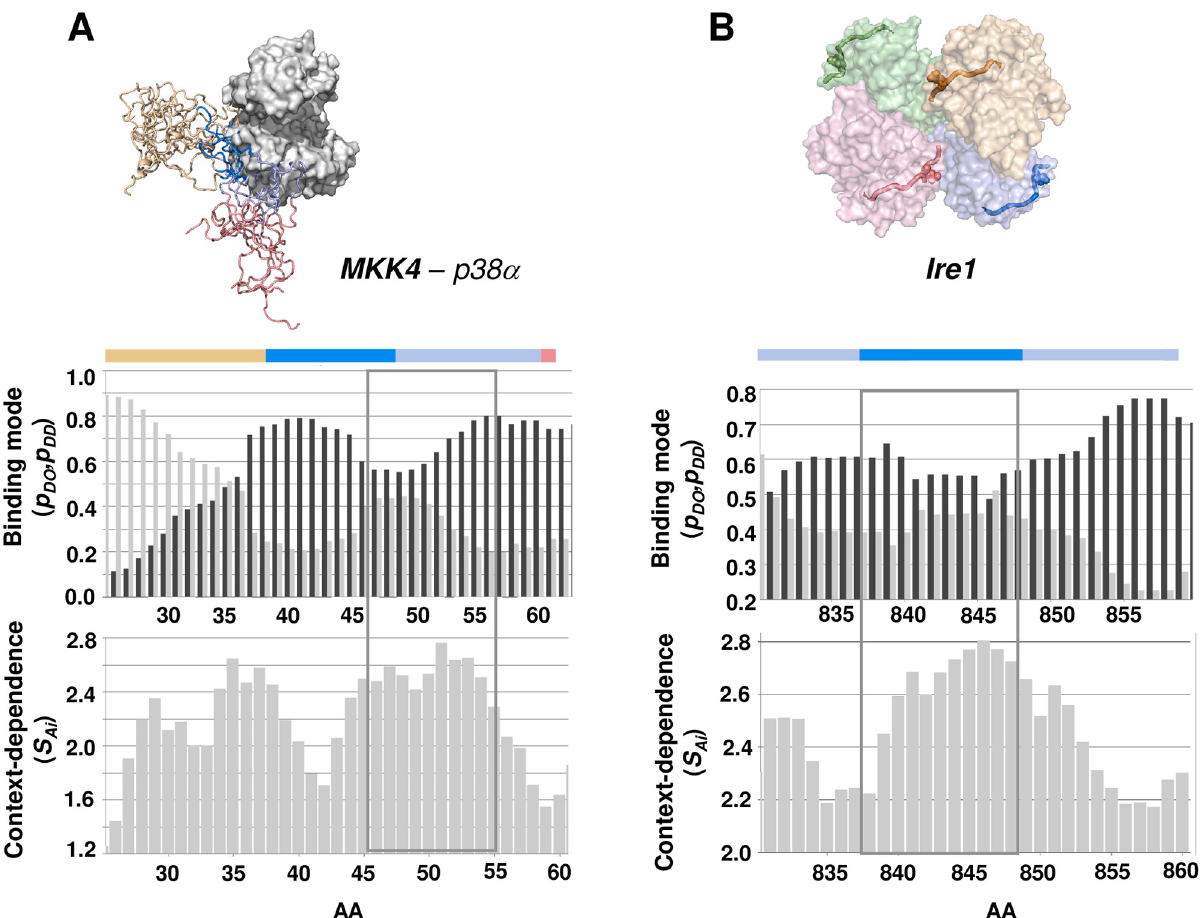
Fig 4. Prediction of context-dependent regions by the FuzPred method. (A) Prediction of binding mode profiles. Comparable probabilities for disorder-to-order transition ( p , dark gray) and disorder-to-disorder transition ( p , light gray) indicate a disordered binding mode for the region of DO DD residues 45–55 (grey box), which involves both the docking and the KIS motif, consistently with the experimental data [33] ( top panel ). Based on the binding profile, this region can fluctuate between ordered and disordered interactions ( bottom panel ), which will depend on the signaling pathway. The values indicate that both the docking motifs and the N-terminal part of the KIS domain are capable to establish different binding modes, consistent S A i with their involvement in disordered interactions. Selected MKK4 conformers docked onto p38 α structure (PDB:1lew). The docking motif (marine) and the KIS domain (light blue) are shown (coordinates as a courtesy of Dr. Malene Ringkjobing-Jensen). (B) Prediction of phosphorylation-induced folding. Trans-autophosphorylation induces folding of the activation loop in the dual-activity enzyme Ire1, which promotes its oligomerisation [19]. Packing of four monomers (wheat, light blue, pale green and light pink surfaces) (PDB: 3fbv) are stabilised by the ordered activation loop (cartoon, the phosphorylated Ser841 is shown by spheres). FuzPred predicts slightly higher probabilities for disorder-to-order transition ( p DO , dark gray, top panel ) for the activation loop (grey box) than for disorder-to-disorder transition ( p , light gray, top panel ), indicating that it can fold upon binding. The high DD values ( bottom panel ) corroborate that the activation loop can sample both disordered and ordered states in the bound form, which could be shifted S A i towards the folded form by